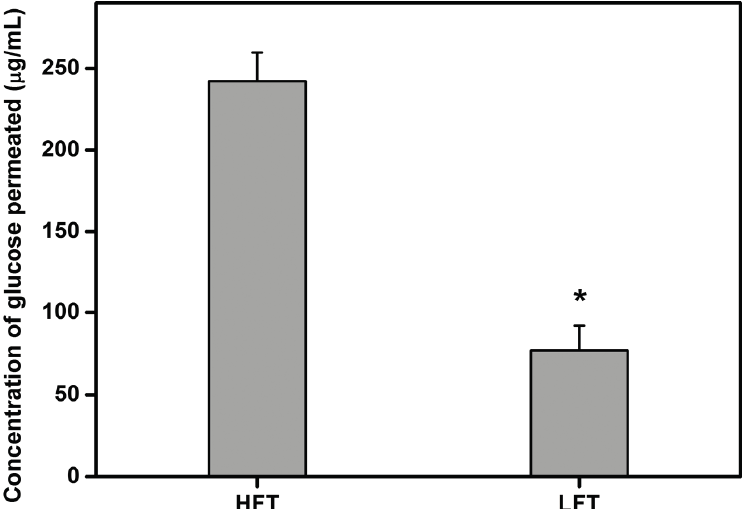
Figure 4. Concentration of glucose permeated through various HA carriers at 34